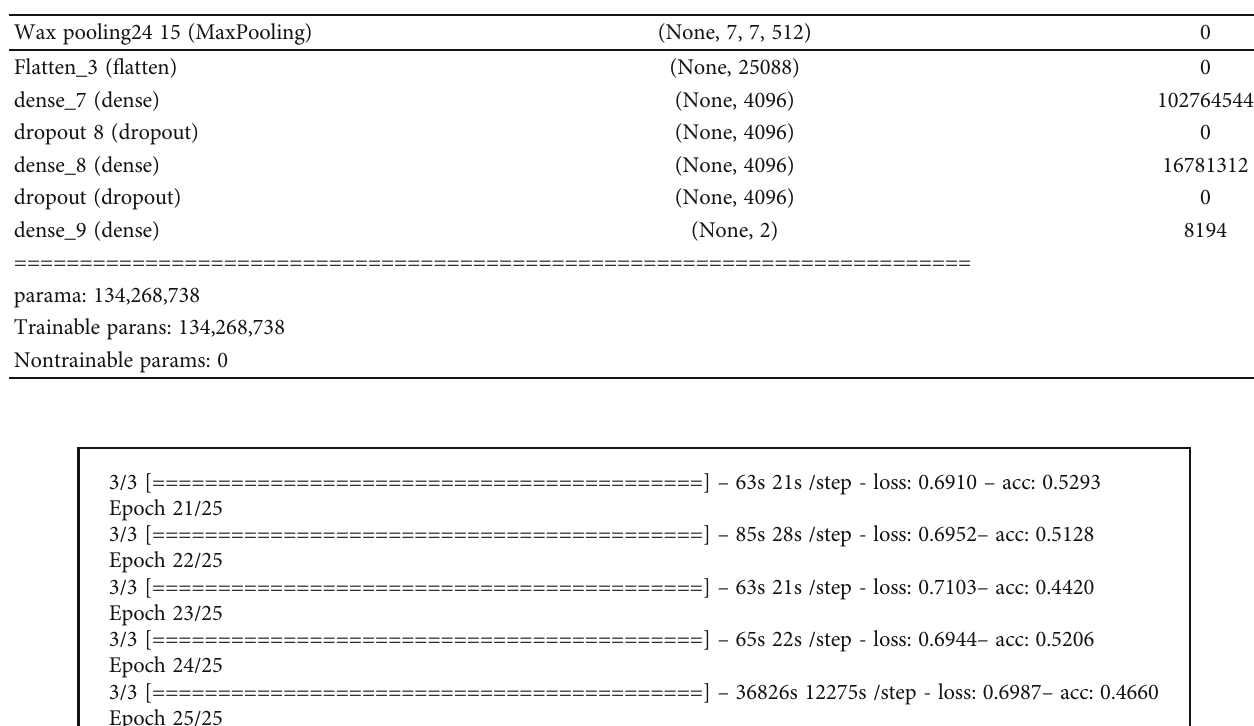
Table 2: Number of parameters that the network can